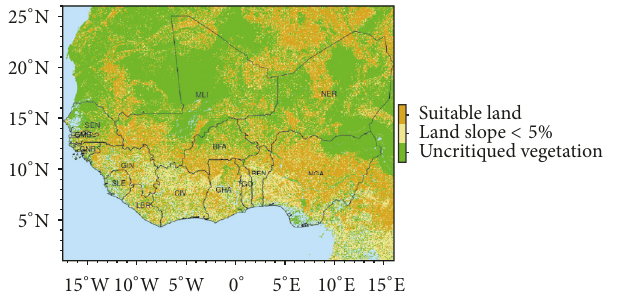
Figure 1: Suitable land for PV power systems generator.